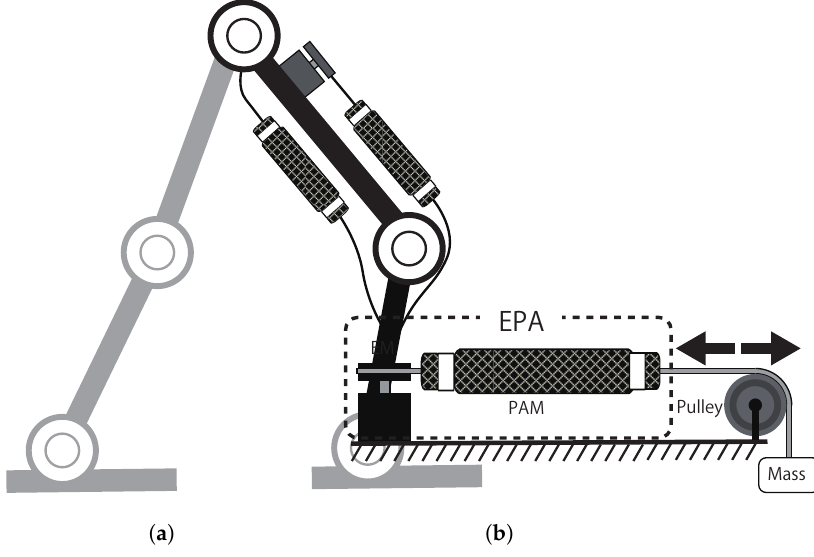
Figure 1. ( a ) A sample design on an EPA (Electric-Pneumatic Actuator) for bipedal locomotion control; and ( b ) the setup for evaluating EPA concept. A fixed mass is connected to serially connected PAM and EM. A desired sinusoidal mass movement is the reference trajectory and the EM controls that with different PAM